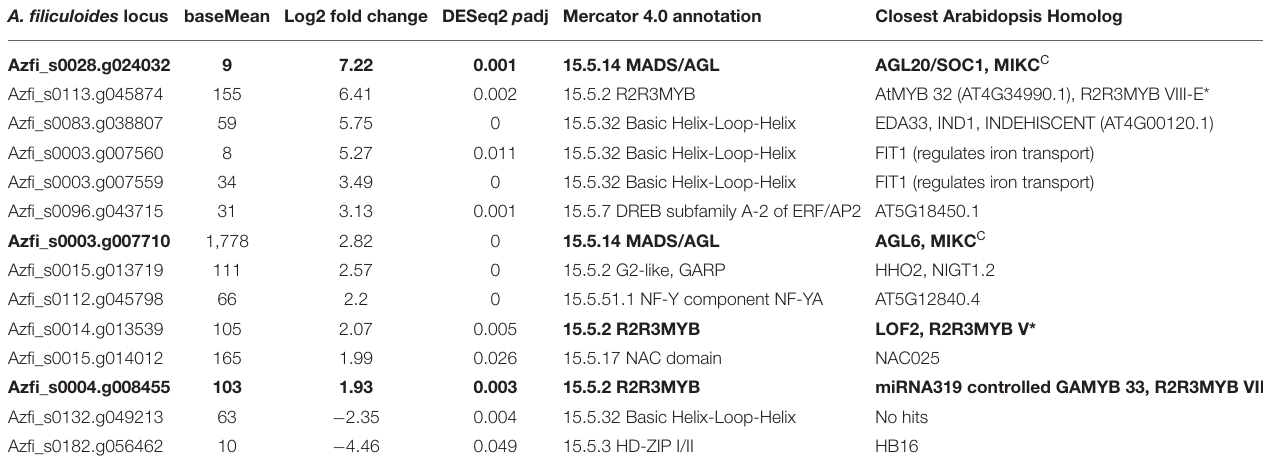
TABLE 2 | Transcription factors (TFs) with largest changes in transcript abundance in sporophytes in tube light (TL) with vs. without far-red (FR). A. filiculoides locus baseMean Log2 fold change DESeq2 p adj Mercator 4.0